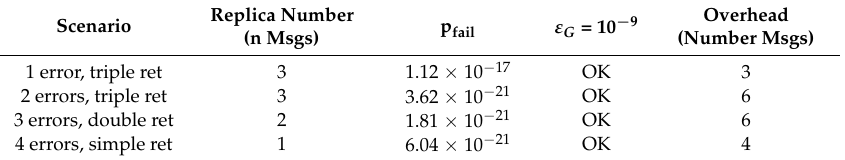
Table 2. Number of replicas needed for a target reliability level in an Aggressive